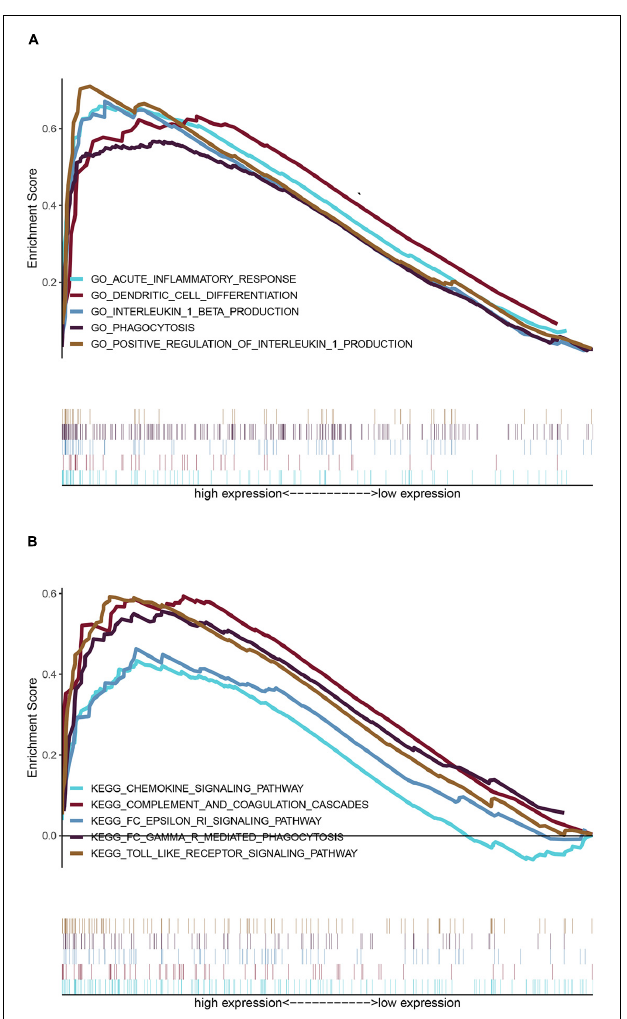
FIGURE 5 | Enrichment analyses via gene set enrichment analysis (GSEA). (A) Five representative enriched immune-related GO gene sets and (B) five representative enriched immune-related KEGG pathways.